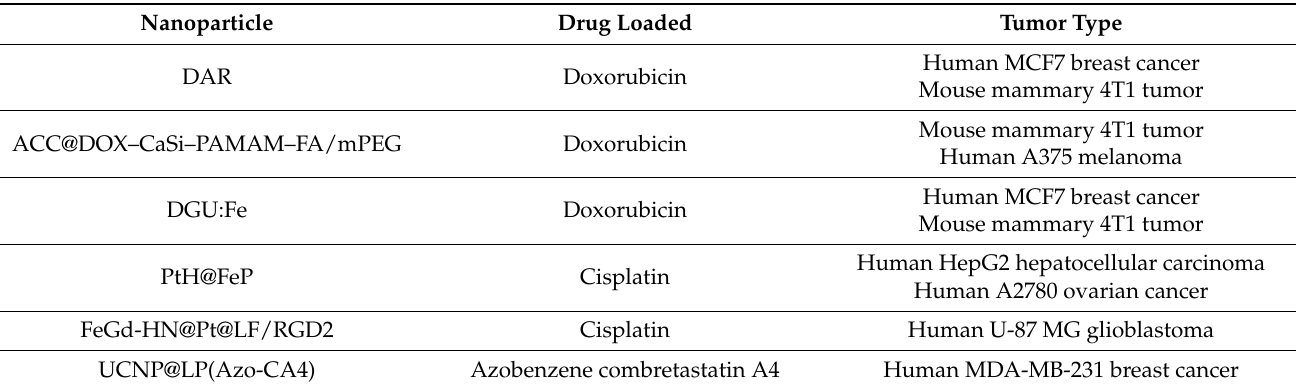
Figure 2. Mechanisms of action of nanoparticles inducing ferroptosis. The figure was prepared using tools from Servier Medical Art (http://www.servier.fr/servier-medical-art, accessed on 15 September 2021). Table 1. Nanoparticles for antitumor drug